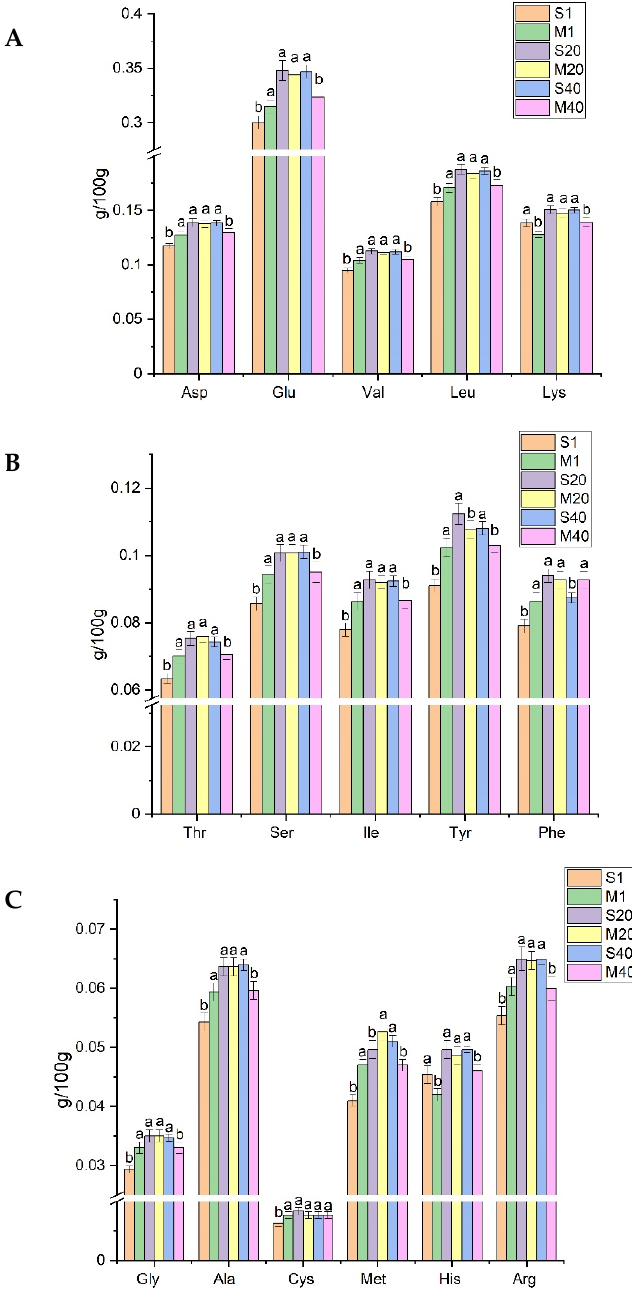
Figure 2. FAA contents of cheese (g/100 g). ( A – C ) are the content of different kinds of FAAs. Different letters indicate a significant difference between mixed-fermentation and single-strain-fermentation cheese obtained on the same day ( p < 0.05). Abbreviations: M, mixed-fermentation cheese; S, single- strain-fermentation cheese. Numbers 1–40 represent different ripening times (in